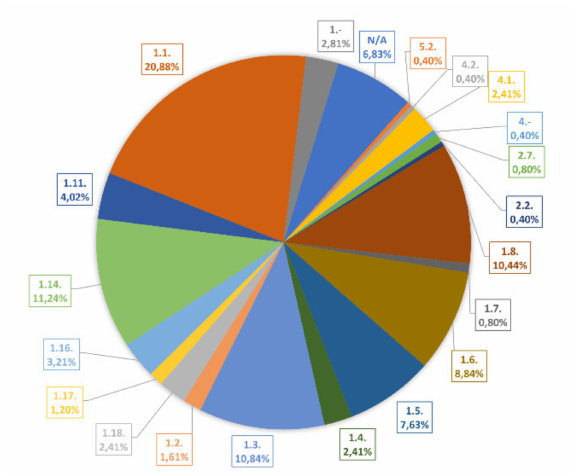
Figure 2. Distribution of the di ff erent enzyme classes among the flavoproteome of A. thaliana . The pie chart was generated by the enzyme classification according to the Enzyme Commission numbers (EC number) as summarized in Table S1: 1. Oxidoreductases; 2. transferases; 4. lyases; 5. isomerases; N / A: Not available. The assignments to the enzyme classes and enzyme subclasses are found in https: // www.brenda-enzymes.org / ecexplorer.php?browser = 1. All Arabidopsis flavoproteins are depicted in Table S1.